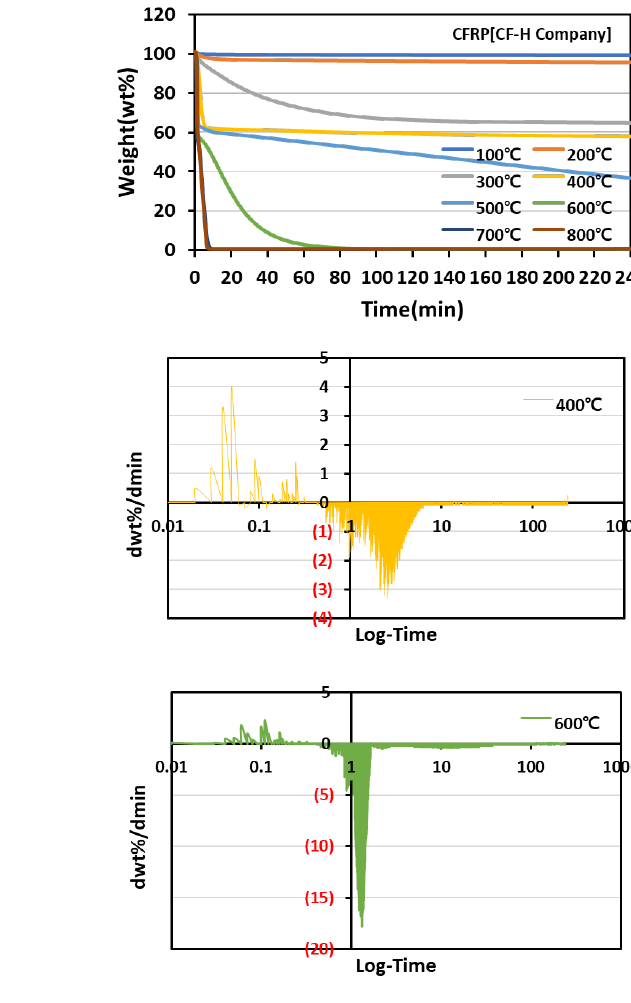
Figure 1. CFRP[CF-H Company] weight change and heat treatment time according to pyrolysis Figure 1. temperature.